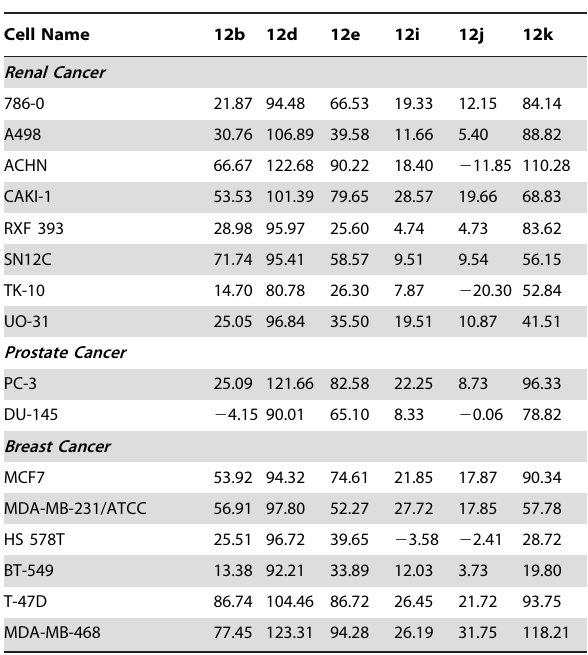
Table 2. Inhibition percentage of compounds (12b, 12d, 12e, 12i, 12j and 12k) at 10 m m dose in the full panel of 60 cell line.